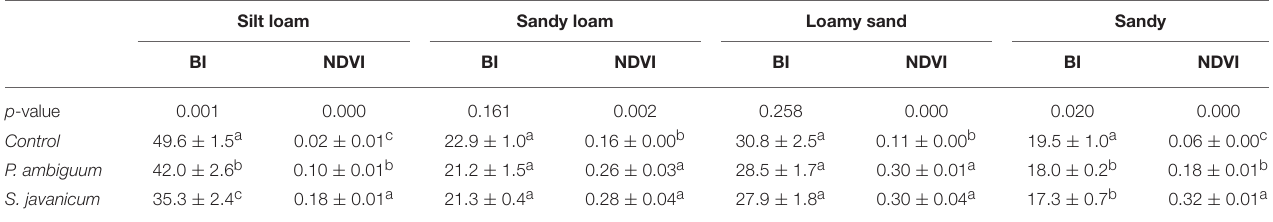
TABLE 3 | Mean ± sd of the Brightness Index (BI) and Normalized Difference Vegetation Index (NDVI) in control and inoculated soils at the end of the incubation period (90 days). Silt loam Sandy loam Loamy sand Sandy BI NDVI BI NDVI BI NDVI BI